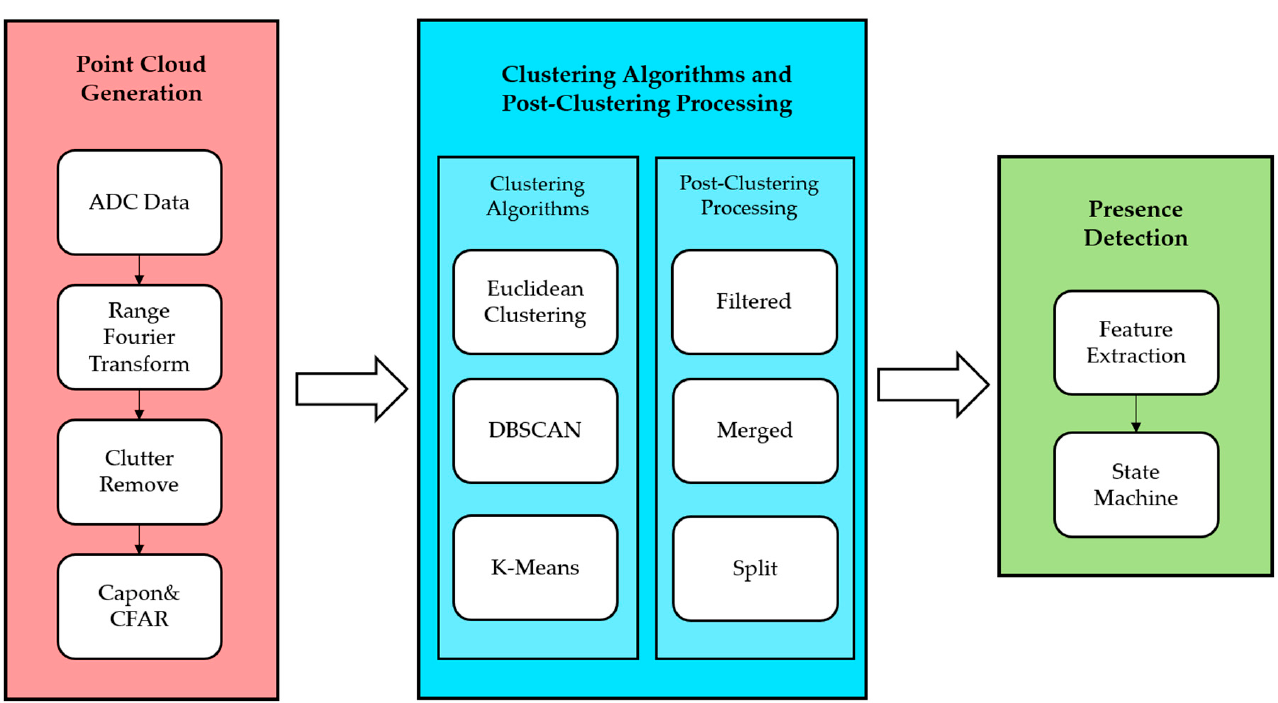
Figure 4. Processing flow from point cloud generation to its clustering, and then to presence detec- tion.